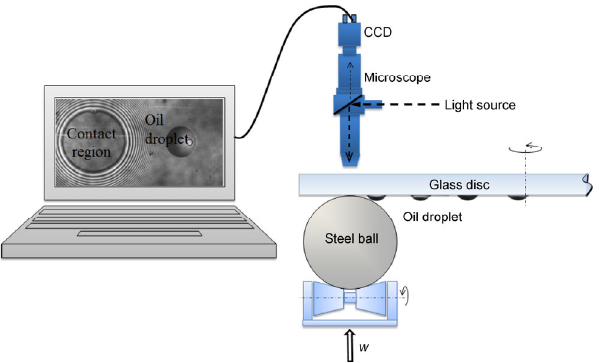
Fig. 1 Illustration of the test rig and the test